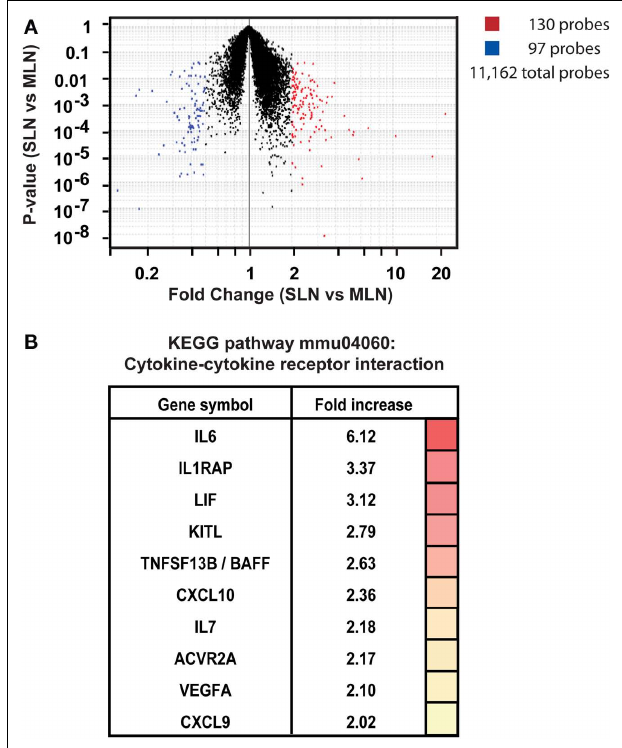
FIGURE 5 | Site-specific transcriptional upregulation of cytokines in FRCs from skin-draining lymph nodes. (A) Microarray analysis comparing FRCs sorted from skin-draining (SLN) or mesenteric lymph nodes (MLN). Dotplot depicts P -value versus fold-change for SLN versus MLN for 15,486 selected probes. Probes upregulated in SLN are shown in red, while probes upregulated in MLN are blue; ( P < 0.05 and fold-change > 2; T -test). n = 4–5 independent replicates. (B) Genes enriched in SLNs encoding cytokines and cytokine receptors (KEGG pathway mmu04060; P < 0.015; modified Fisher’s exact test with Benjamini correction).The fold-increase in mean expression in SLNs compared to MLNs is